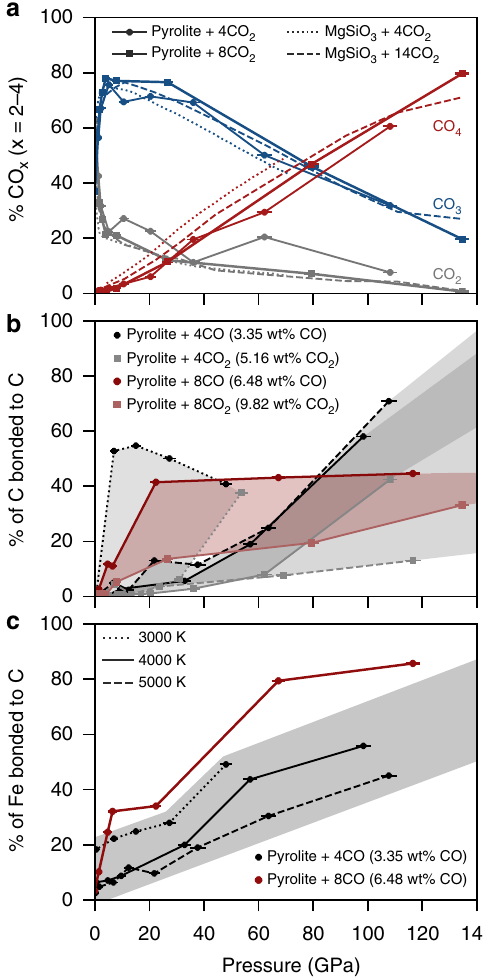
Fig. 1 Carbon chemistry and polymerization. a Relative abundance of CO 2 , CO 3 , and CO 4 as a function of pressure for pyrolite + 5.16 wt% CO 2 (4CO 2 units per cell) and pyrolite + 9.82 wt% CO 2 (8CO 2 units per cell) at 4000 K. We compare our results to those of ref. 21 for MgSiO 3 + 5.2 wt% CO 2 (4CO 2 units per cell) and MgSiO 3 + 16.1 wt% CO 2 (14CO 2 units per cell), also at 4000 K. b The percent of polymerized carbon (i.e., the percent of carbon atoms that are bonded to another carbon atom) as a function of pressure for pyrolite + 4CO (3.35 wt% CO), pyrolite + 4CO 2 (5.16 wt% CO 2 ), pyrolite + 8CO (6.48 wt% CO), and pyrolite + 8CO 2 (9.82 wt% CO 2 ) at 3000 K (dotted line), 4000 K (solid line), and 5000 K (dashed line). Shaded regions represent the range from the more oxidized to the more reduced melts. for each temperature and/or carbon content. c The percent of iron atoms that are bonded to carbon in pyrolite + 4CO (3.35 wt% CO) and pyrolite + 8CO (6.48 wt% CO) at 3000 – 5000 K. Shaded region represents the approximate region that pyrolite + 4CO encompasses to highlight the contrast with pyrolite + 8CO. Error bars on pressures are standard deviations determined from the